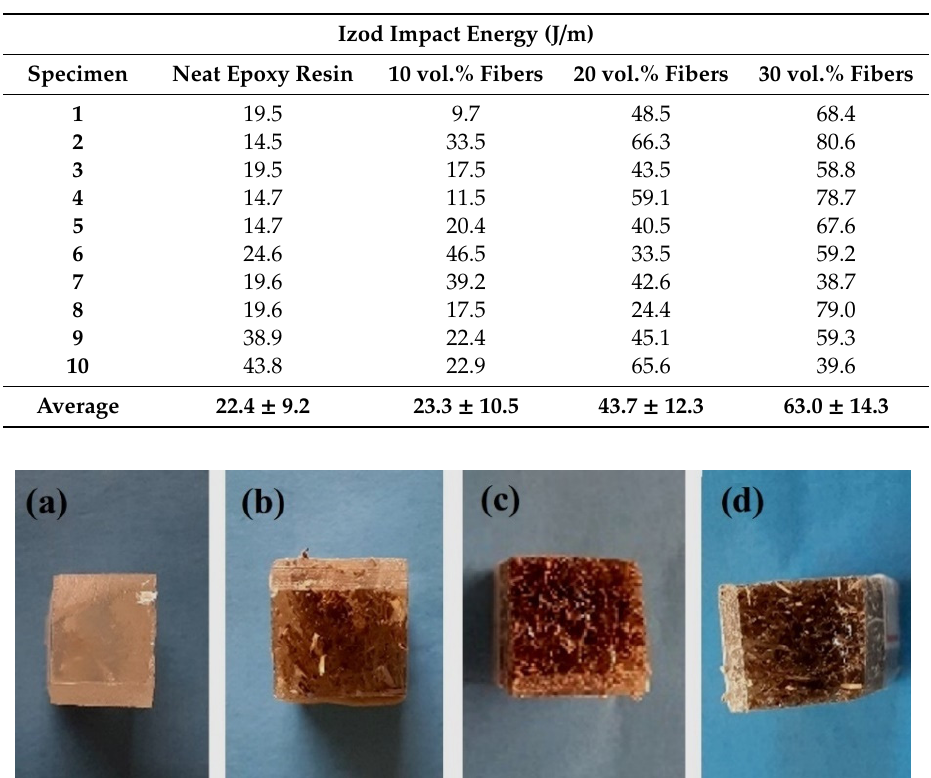
Figure 4. Izod impact energy as a function of the fiber fraction for the neat epoxy resin and CM fiber- reinforced composites.